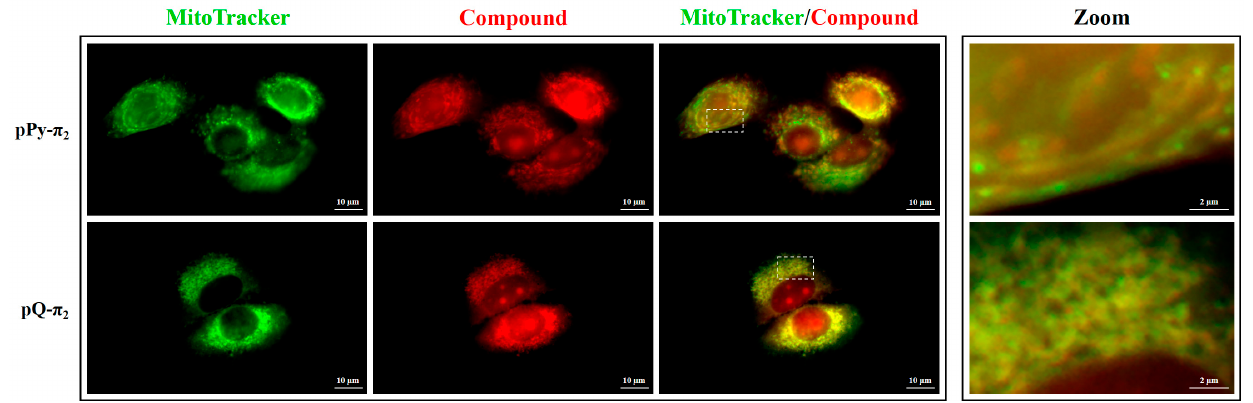
Figure 8. Left : representative fluorescence microscopy images of fixed A549 cells stained with 200 nM MitoTracker TM (green, FITC filter), 10 µM pPy- π 2 and pQ- π 2 compounds (red, TRITC filter), and the relative merged images. Image magnification: 60×. Right : zoom-in of representative cells.